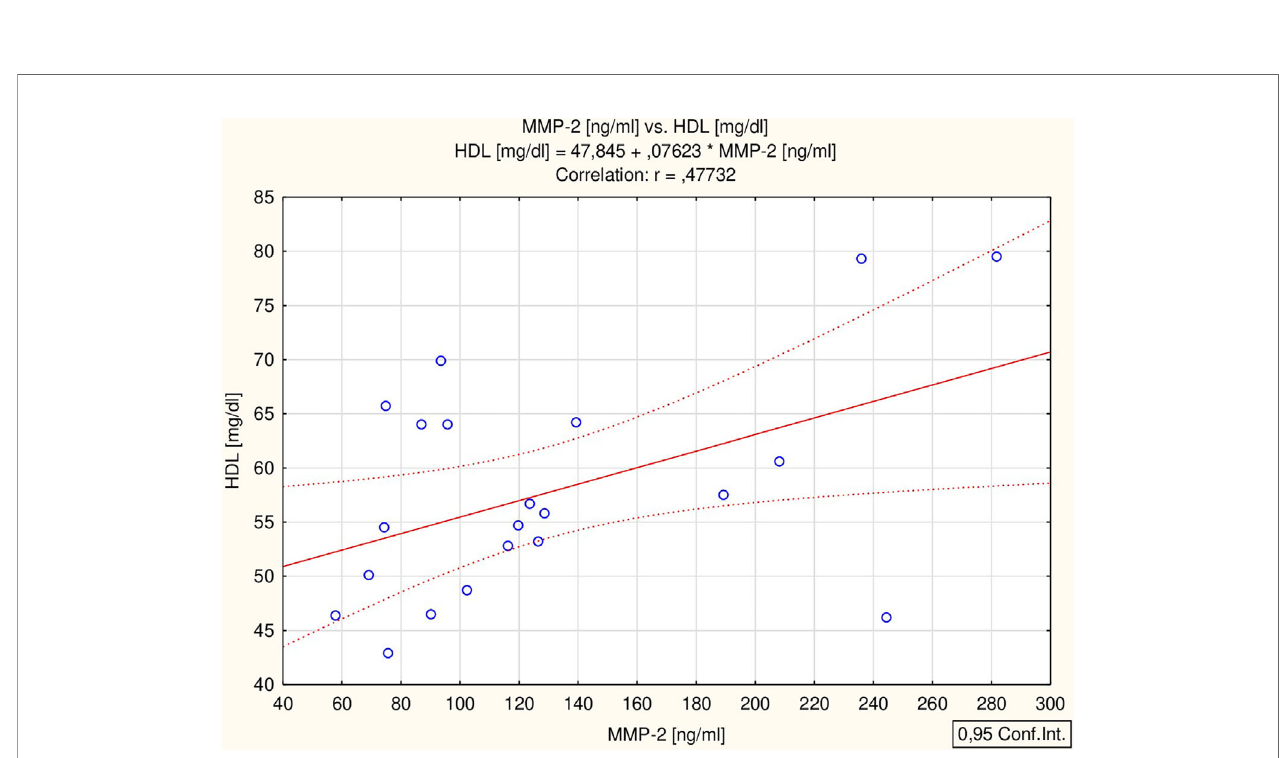
FIGURE 2 | Correlation of MMP-2 with HDL. MMP-2, matrix metalloproteinase-2; HDL, HDL cholesterol.